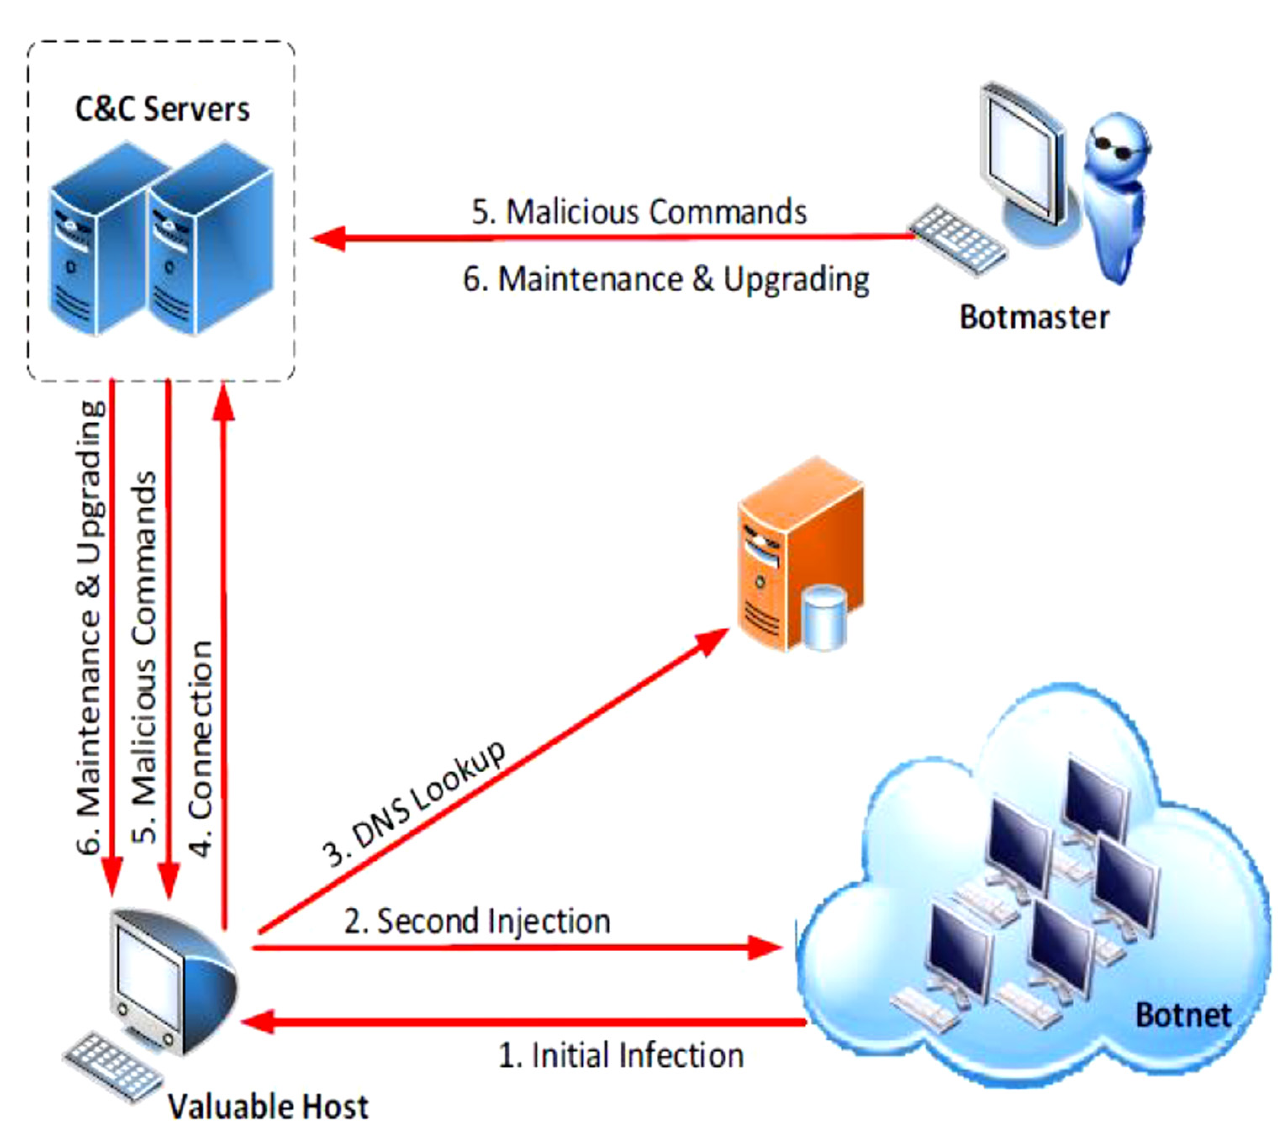
Figure 1. Botnet lifecycle.